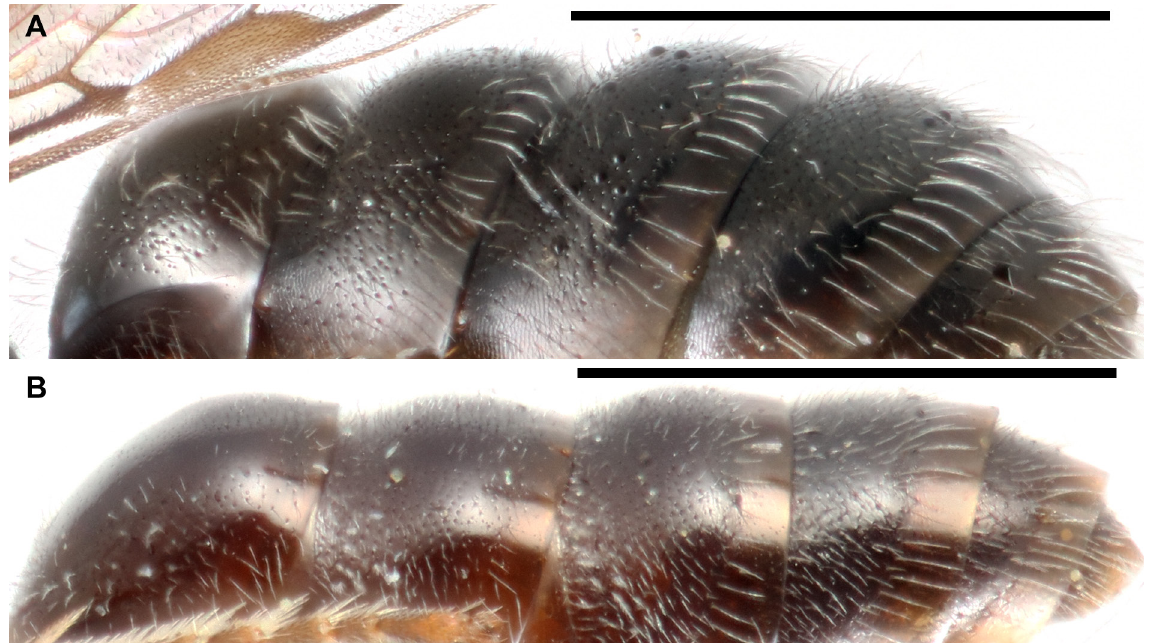
Fig. 106. Metasomal terga. A . Lasioglossum coactus (Cresson, 1872), ♂, T1–T3 each strongly convex with abruptly depressed apical rim. B . L. helianthi (Cockerell, 1916), ♂, T1–T3 each weakly convex with apical rim weakly depressed. Scale bars = 1 mm.